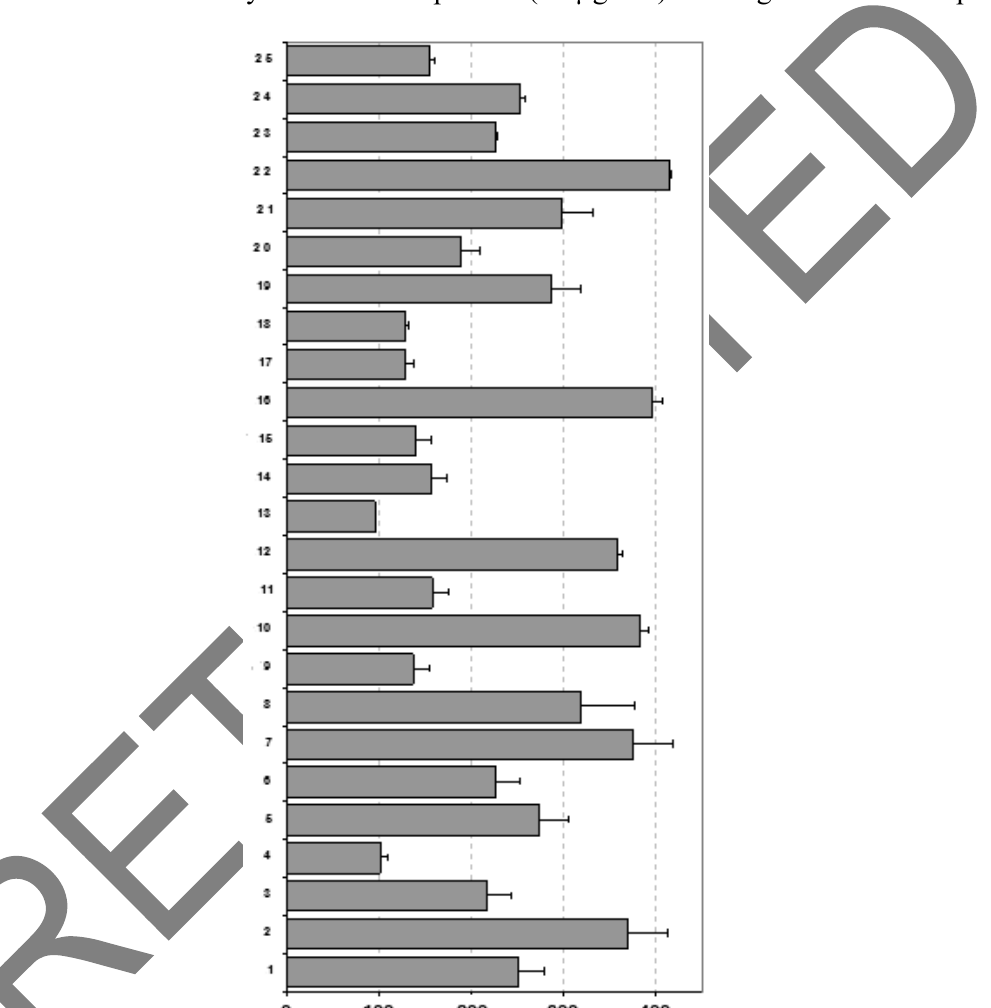
Figure 1. The effect of the synthesized compounds (20 µg/mL) on the growth of macrophages.